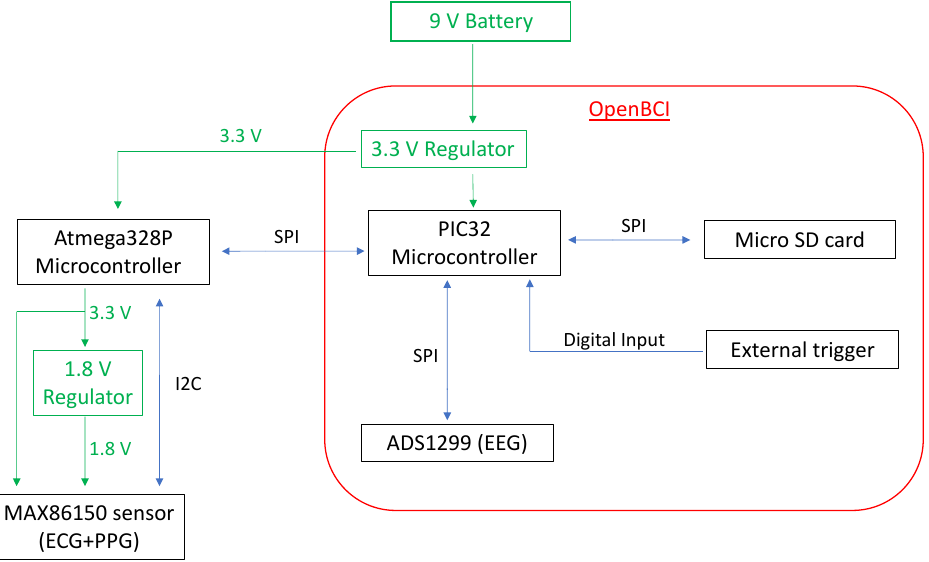
Figure 4. Schematic diagram of the operation and communication of the designed monitoring sys ‐ tem.